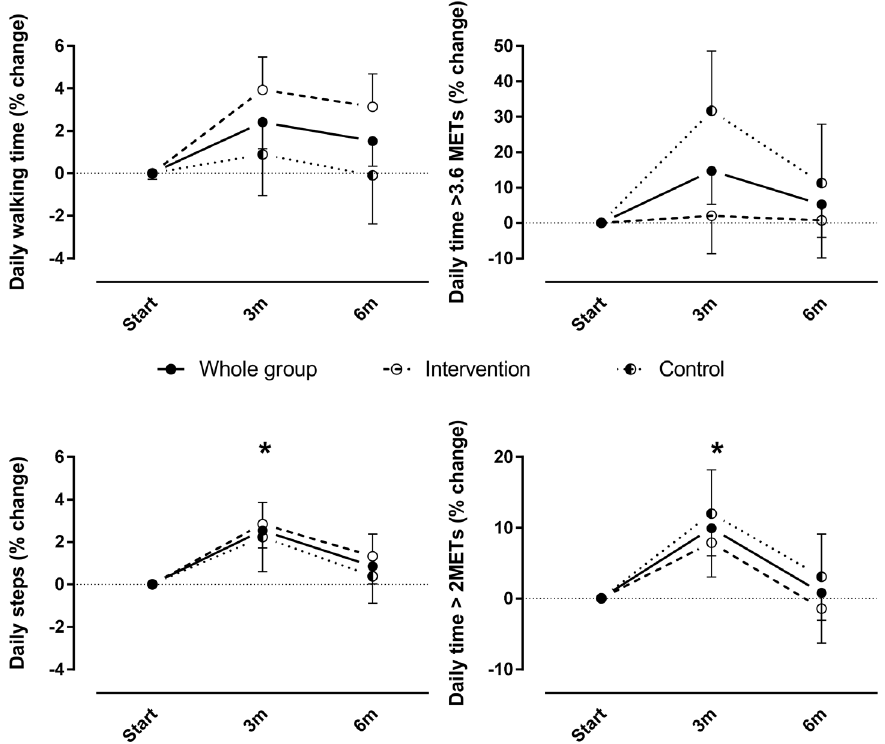
Fig 2. Relative changes in daily time spent walking, daily steps, daily timespent in at least moderate intenseactivities ( > 3.6 metabolic equivalents) and at least mild intenseactivities ( > 2.0 metabolic equivalents) after three months (3m) and after six months of rehabilitation (6m) compared tobaseline. Data are expressed as percentageof change of least square means compared to baseline. No intervention * time effects were observed. * indicates time effect for the whole group (p < 0.05comparedto